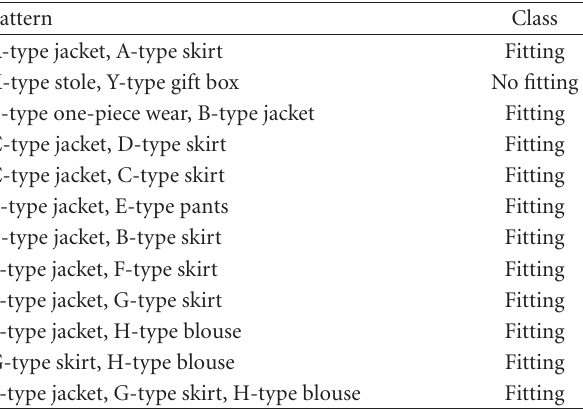
Table 13: Discovered patterns from α shop.